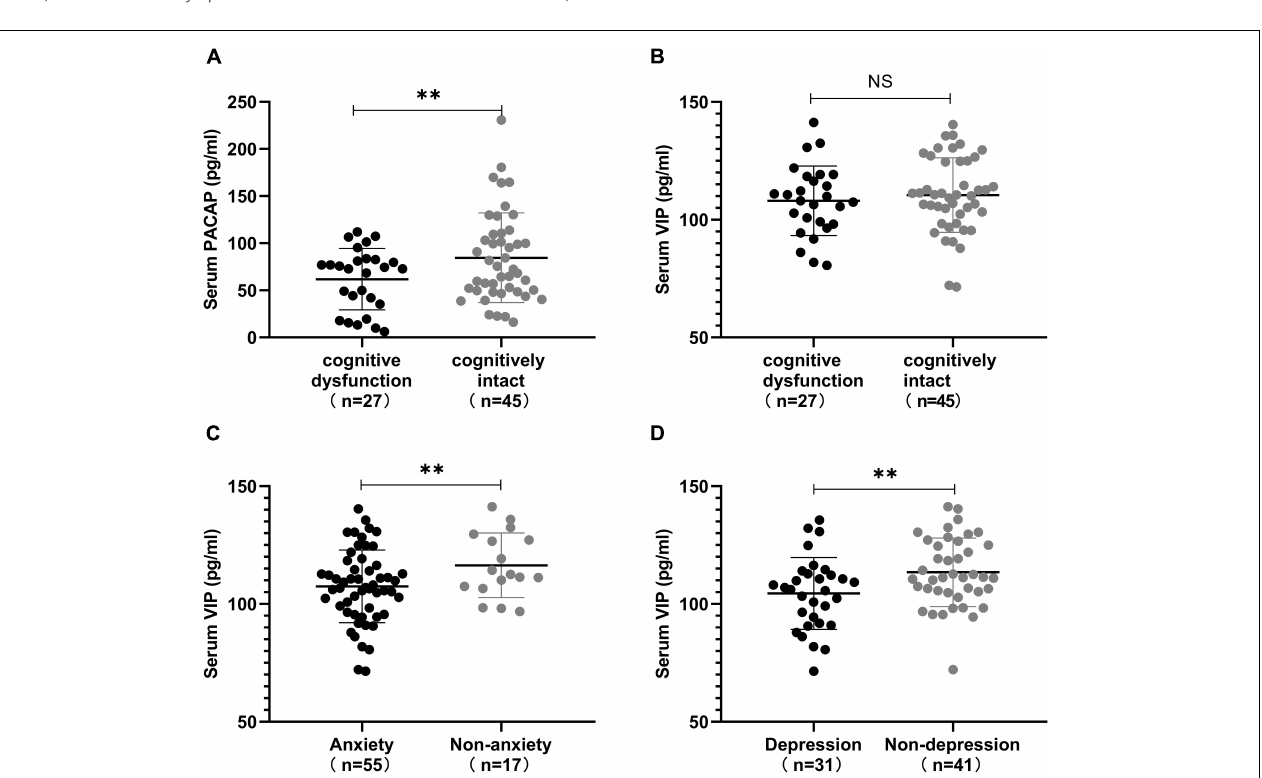
FIGURE 6 | Correlation between serum pituitary adenylate-cyclase activating polypeptide (PACAP) and vasoactive intestinal peptide (VIP) levels, and non-motor symptoms. (A) Serum PACAP levels in different subgroups defined by the presence or absence of cognitive dysfunction in Parkinson’s disease (PD) patients. Patients in the cognitively intact subgroup showed higher levels of serum PACAP than in the cognitive dysfunction subgroup. (B) Serum VIP levels in different subgroups defined by the presence or absence of cognitive dysfunction in PD patients. Patients in the cognitively intact subgroup showed higher levels of serum VIP than in the cognitive dysfunction subgroup. (C) Serum VIP levels between the anxiety and non-anxiety subgroups in PD patients. Patients in the non-anxiety subgroup showed higher levels of serum VIP than those in the anxiety subgroup. (D) Serum VIP levels between the depression and non-depression subgroups in PD patients. Patients in the non-depression subgroup showed higher levels of serum VIP than those in the depression subgroup. Values are presented as the mean ± SD; NS, no significance; ∗∗ P <